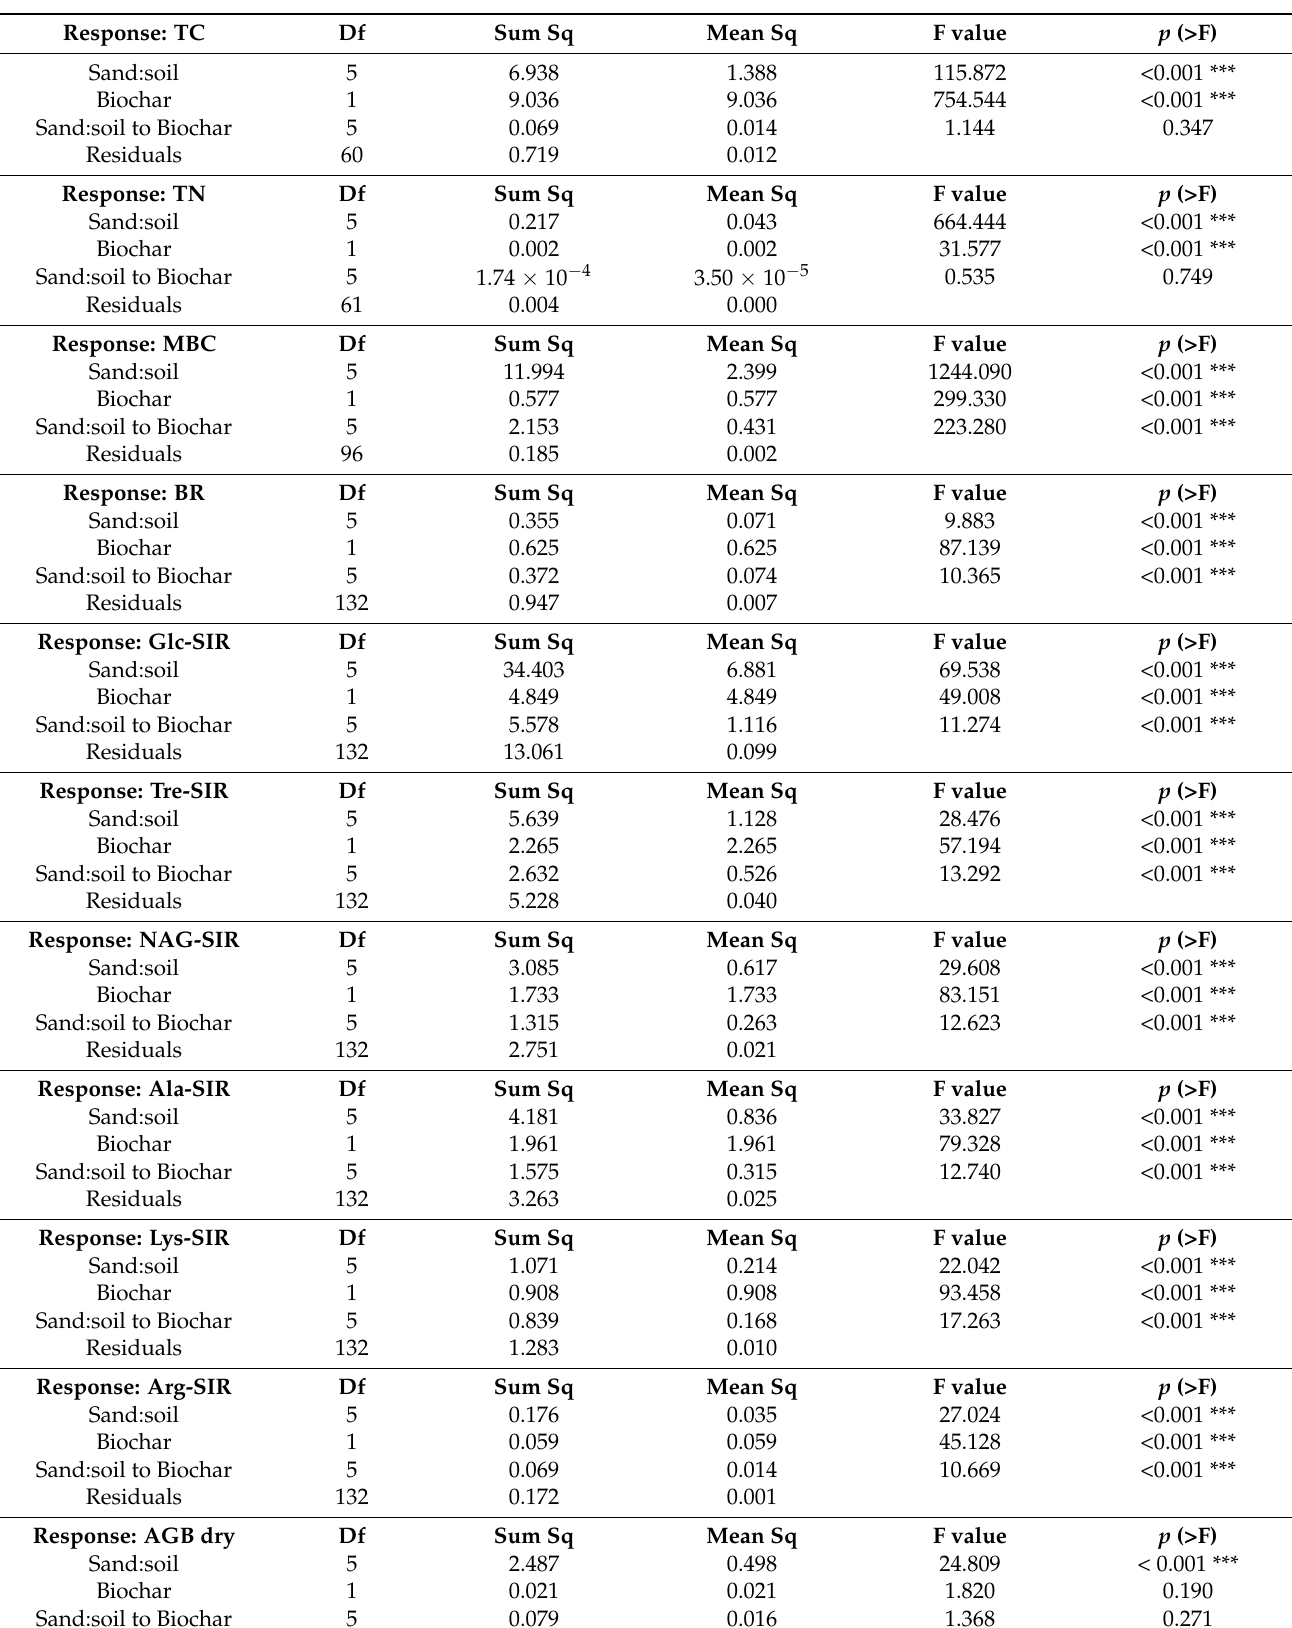
Table A2. Results of two-way analysis of variance